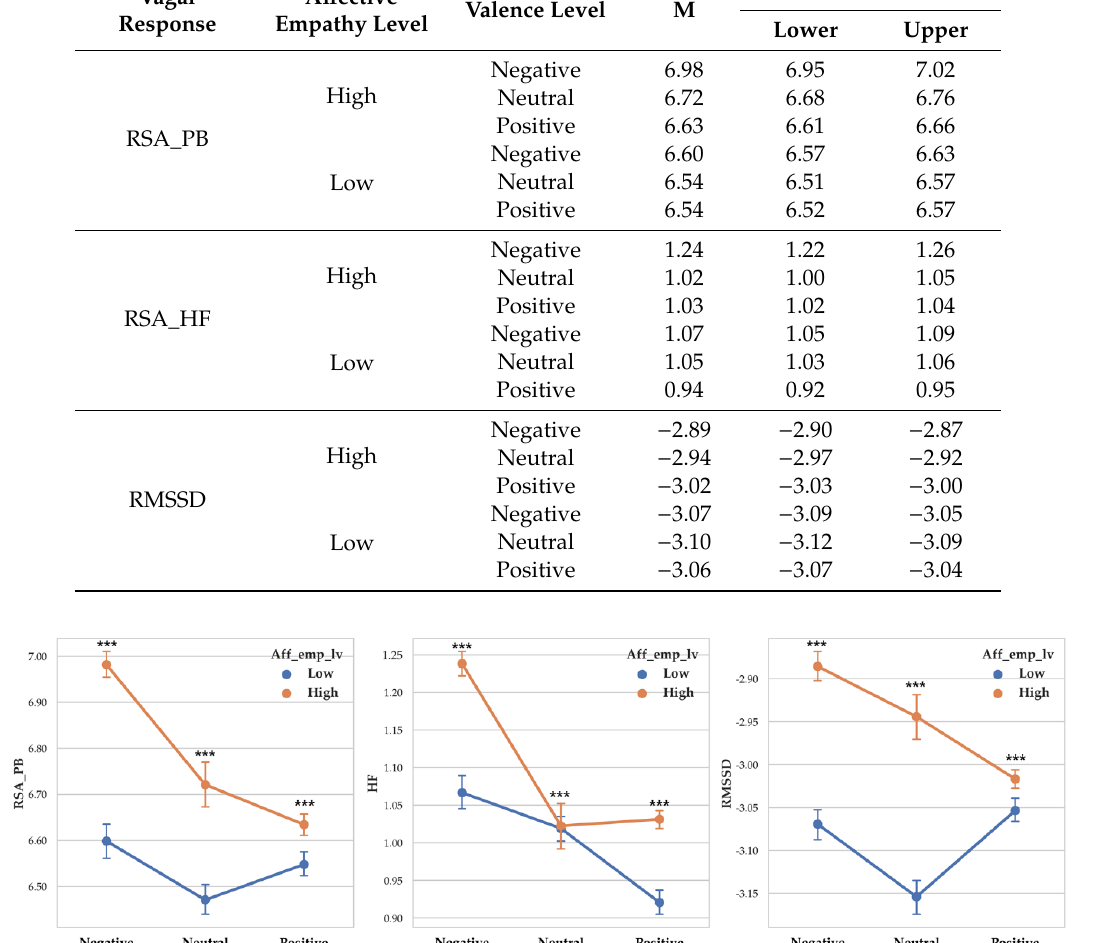
Table 6. Descriptive statistics of vagal response depending on affective empathy level and valence. M = Mean, SD = Standard deviation. 95% CI = 95% of confidence interval. Vagal